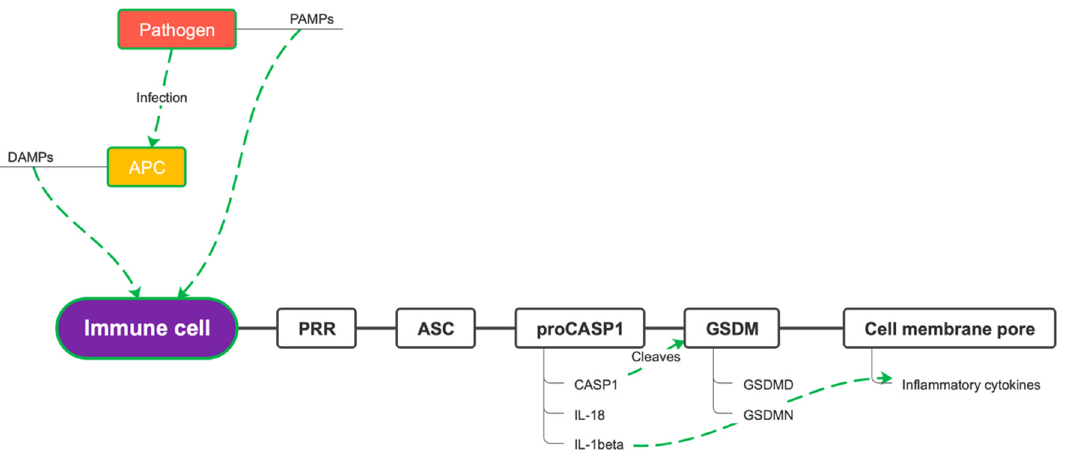
Figure 3. Gasdermin pore formation. PAMPs = pathogen-associated molecular patterns; DAMPs = damage-associated molecular patterns; APC = antigen-presenting cell; PRR = pattern recognition receptor; ASC = apoptosis-associated adaptor speck-like protein containing a caspase recruitment domain; pro-CASP1 = pro-caspase-1; CASP1 = caspase-1; IL-1 beta = interleukin-1 beta; IL-18 = interleukin-18; GSDM = gasdermin; GSDMD = gasdermin-D.